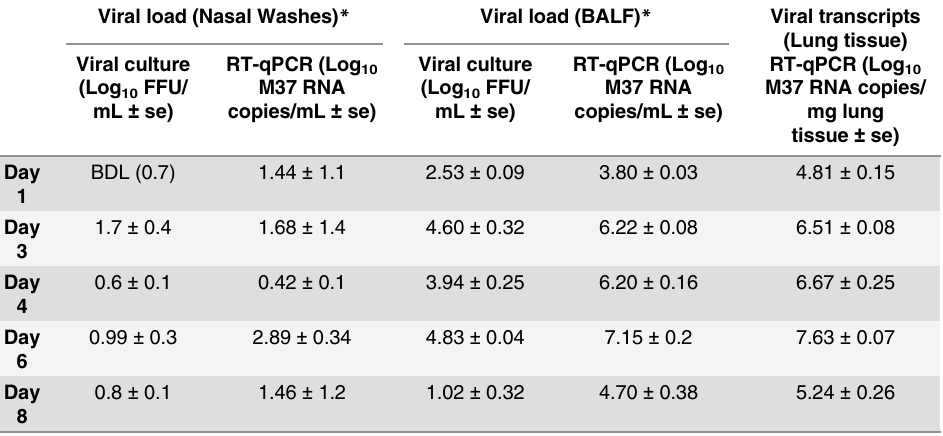
Table 3. Quantification of RSV replication via RT-qPCR and infectious focus assay in lambs inocu- lated with M37 hRSV.